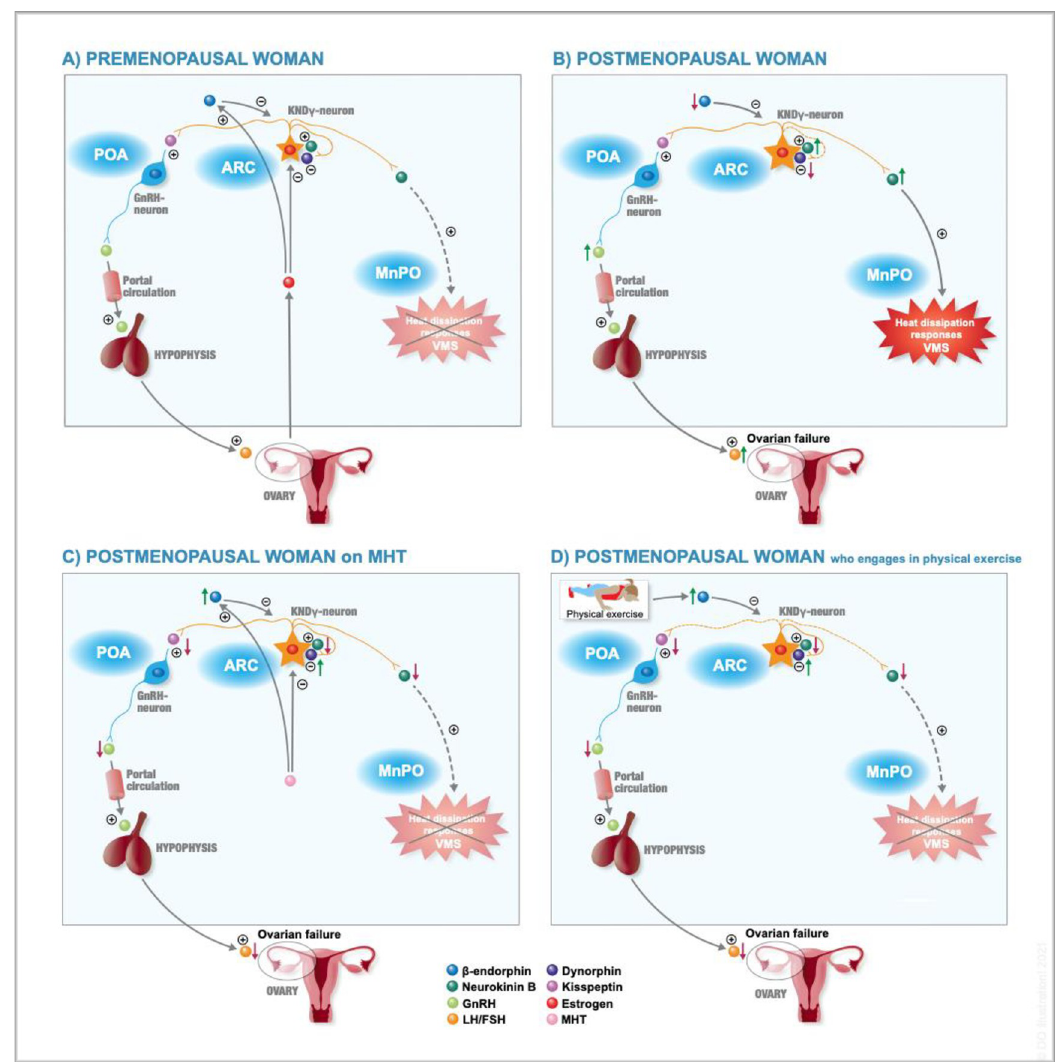
Fig 2. A-D : Illustrations to the possible cause of vasomotor symptoms and how Menopausal Hormone Therapy (MHT) and physical exercise may relieve them. A PREMENOPAUSAL WOMAN: The GnRH cell bodies in the preoptic area (POA) of hypothalamus constitute the central regulation of reproduction. The pulsatile GnRH secretion into the hypophyseal circulation triggers the production and release of the gonadotropins Luteinizing Hormone (LH) and Follicle Stimulating Hormone (FSH). Since GnRH neurons do not express steroid receptors, evidence suggests that indirect steroid feedback is mediated by Kisspeptin/ Neurokinin B/Dynorphin (KND γ ) neurons. Via the neuropeptide kisspeptin, the KND γ neurons stimulate both the GnRH pulse amplitude and frequency. Except their steroid-responsiveness and involvement in reproduction, KND γ neurons also project to heat dissipation neurons in POA and its Median Preoptic Nucleus (MnPO), mainly via the neuropeptide Neurokinin B (NKB). The MnPO neurons constitute the primary autonomic thermoregulatory area, capable to initiate effector responses in order to stabilize the inner core temperature in a changing ambient environment. Since estrogen acts stabilizing on the thermoregulatory center by widening the thermoneutral zone, premenopausal women are less afflicted by vasomotor symptoms (VMS). B POSTMENOPAUSAL WOMAN: In postmenopausal women, the ovarian failure leads to reduced negative feedback from sex steroids, which is associated with increased KND γ neuron activity. The gene expression of dynorphin mRNA is downregulated while the expression of both kisspeptin and NKB are simultaneously upregulated. The reduced levels of centrally produced β - endorphin further increase the KND γ neuron activity causing hypertrophy of the nucleus. Consequently, there is an instability in the thermoregulatory center in MnPO, narrowing the thermoneutral zone, which in turn facilitates inappropriate activation of thermoregulatory effectors for heat dissipation, clinically experienced as VMS. Moreover, the increased kisspeptin expression stimulates GnRH neurons which both enhances the gonadotropin pulse frequency and amplitude from the pituitary. C POSTMENOPAUSAL WOMAN ON MHT: Endogenous estrogen and menopausal hormone therapy (MHT) modulate the thermoregulatory and reproductive functions indirectly via the hypothalamic opioid system. Both β -endorphin and dynorphin signaling lower the KND γ neuron activity, leading to reduced levels of the stimulatory neuropeptides kisspeptin and NKB. This